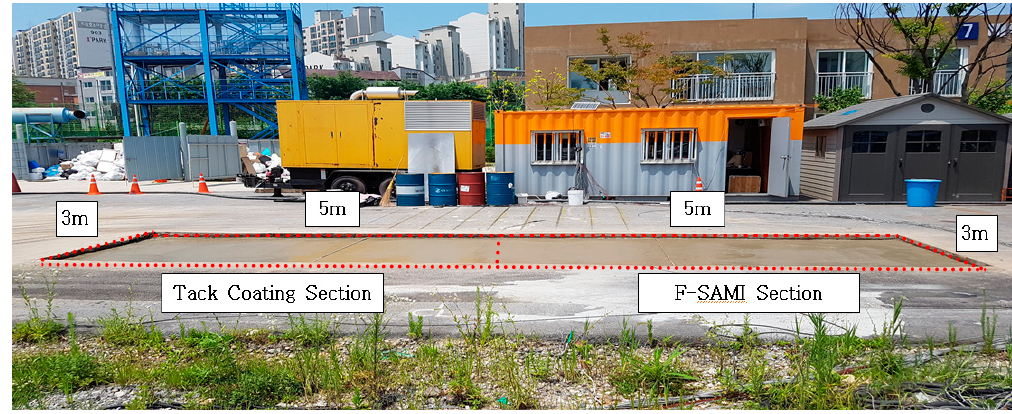
Figure 7. APT test section.